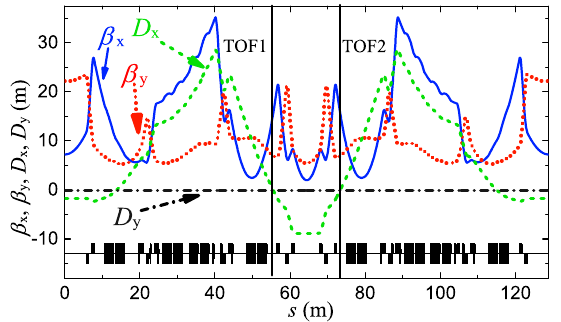
FIG. 1. Calculated horizontal, β x ð s Þ (blue solid line), and vertical, β y ð s Þ (red dotted line), betatron amplitude functions and the horizontal, D x ð s Þ (green dashed line), and vertical, D y ð s Þ (black dashed and dotted line) dispersion functions of the CSRe lattice employed in this experiment. Calculations were done with WINAGILE code [35]. The positions of the two TOF detectors are marked by black solid vertical